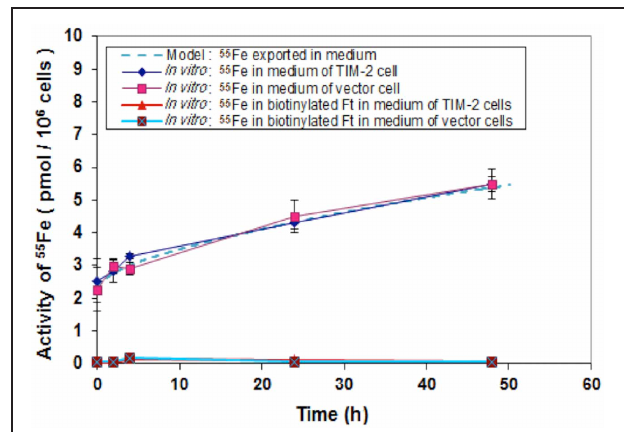
FIGURE 7 | Comparison of iron export rates between laboratory data and simulation. Cells that had been preloaded with Tf- 55 Fe were washed and changed into normal growth media. Media were collected at different time points over a 48h period and 55 Fe amounts in media were counted. Data shown are means and standard deviations for triplicate replication of the experiment. The experiment was performed in triplicate.